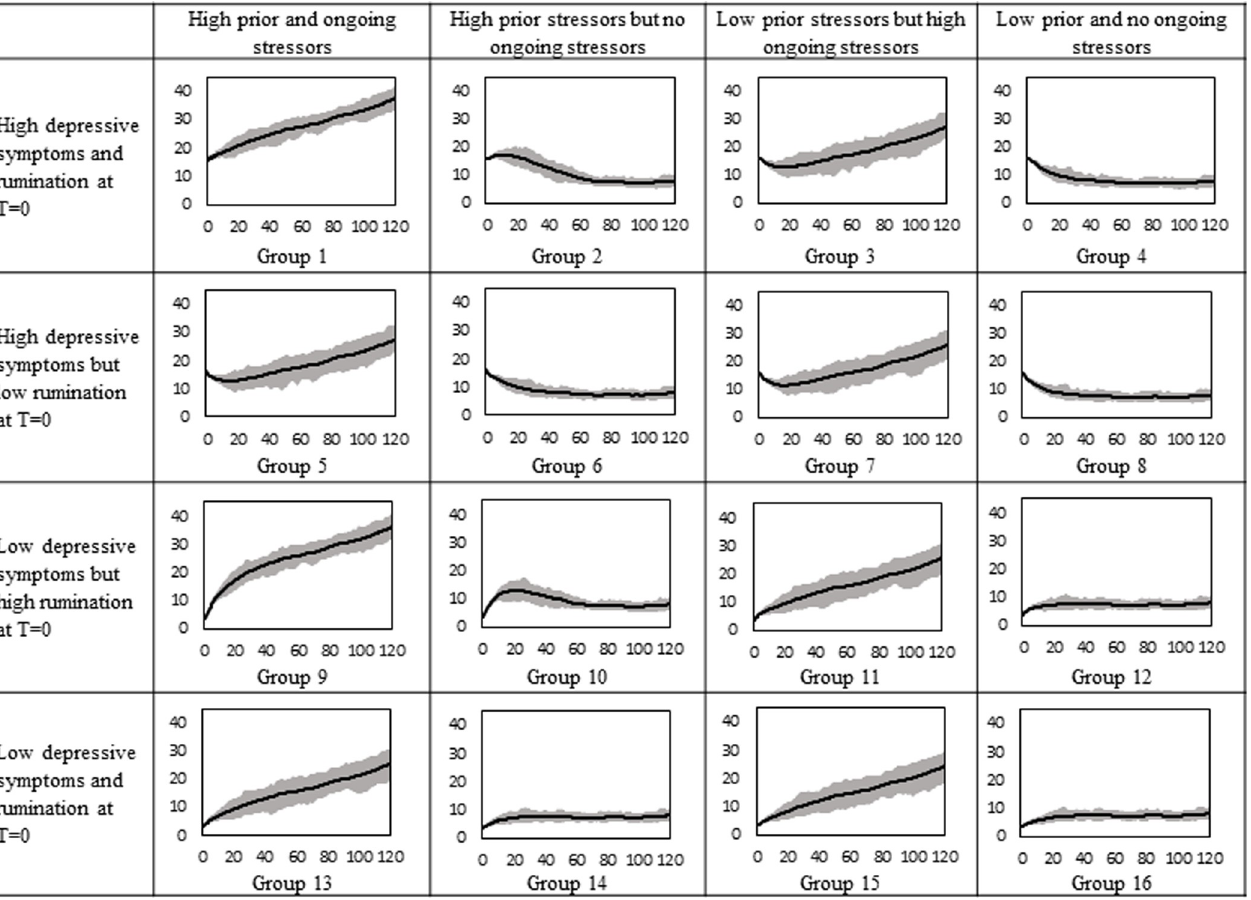
Fig 2. Simulated depressive symptoms over 120 months for 16 female groups.